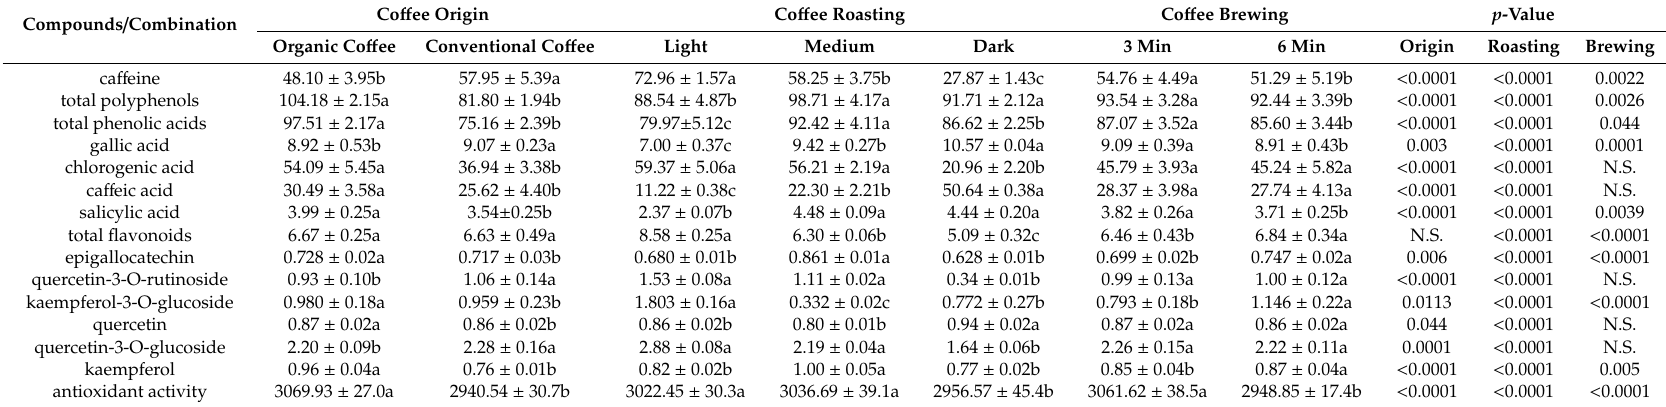
Table 2. Quantity and quality of polyphenols and ca ff eine (in mg 100 mL − 1 ), antioxidant activity (in µ M of Trolox equivalents (TE) 100 mL − 1 ) in examined co ff ee